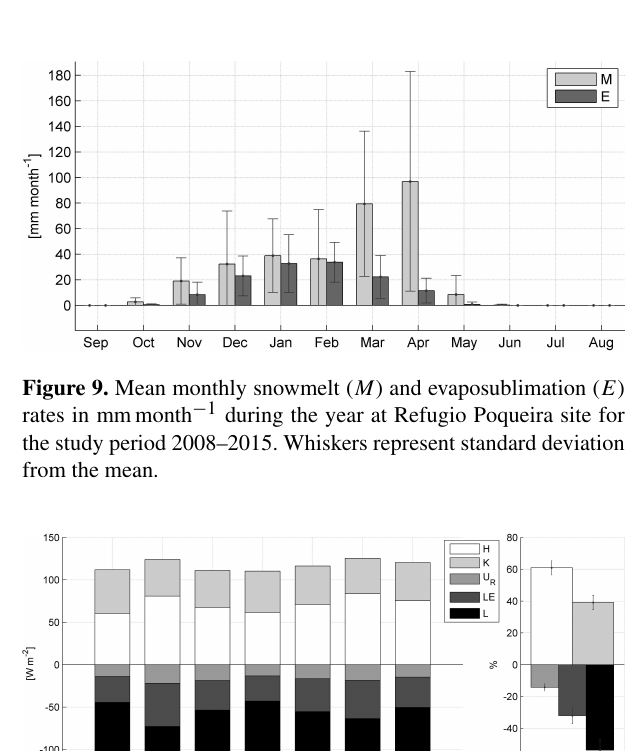
Figure 8. Probability density function of the mean snowmelt ( M ) and evaposublimation ( E ) rates in mm 5min − 1 at the Refugio Poqueira site from the hydrological year 2008/2009 to 2014/2015. The zoom on each plot shows the distribution without the influence of the zero-values.